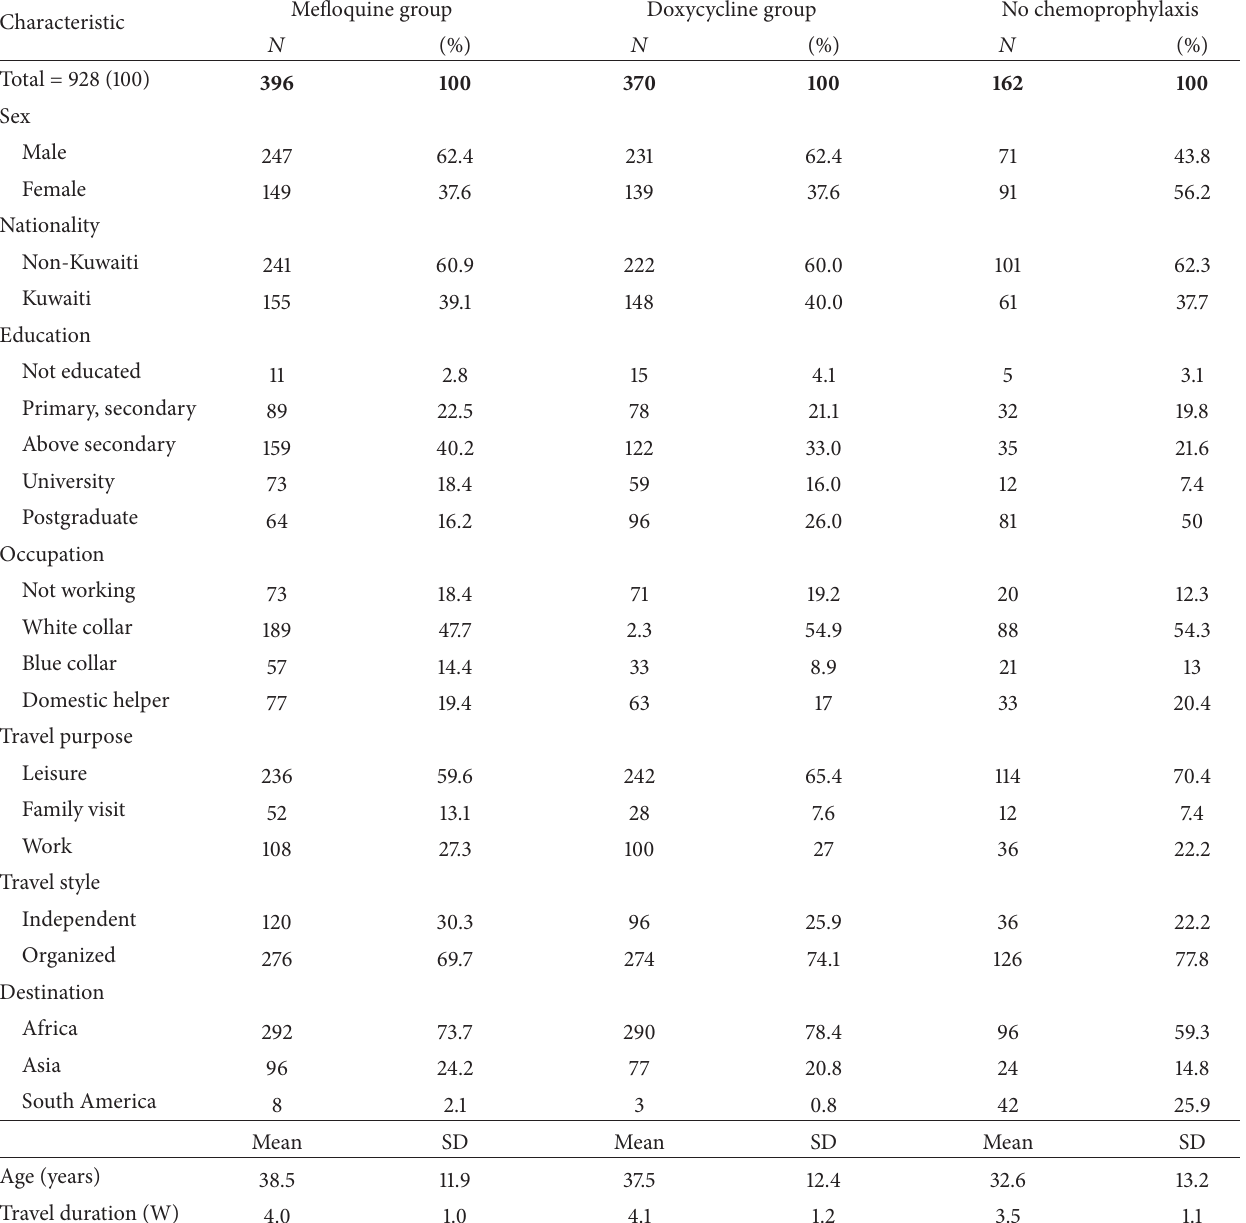
Table 1: Sociodemographic characteristics of the studied groups.